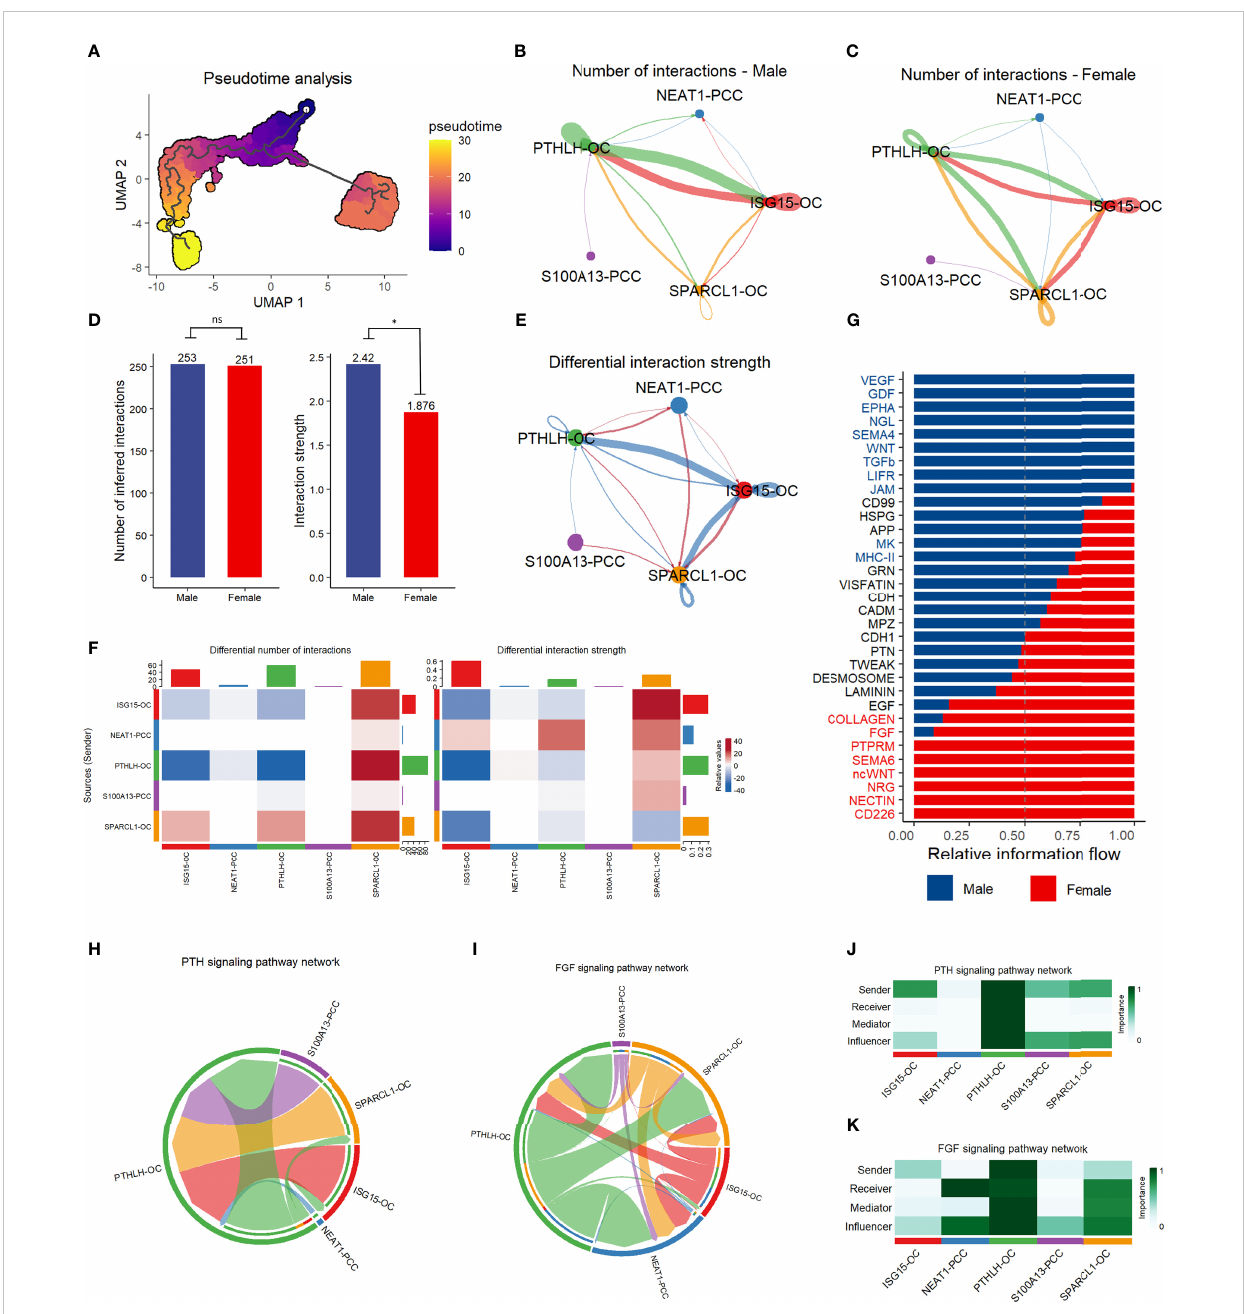
FIGURE 6 Pseudotime trajectory analysis and communication analysis of parathyroid cells. (A) Pseudotime trajectory analysis of parathyroid cell developmental stages. The colormap shows the pseudotime trajectory (B, C) String plot of the aggregated cell-cell communication network of male (B) and female (C) parathyroid cells. (D) Interaction number and strength comparison between male and female patients *= p < 0.05, ns, not statistically signi fi cant (unpaired t-test). (E) Differential interaction strength comparison between male and female patients. (F) Heatmap of interaction numbers and strength in different cell subpopulations. (G) Pathway comparison between male and female patients by parathyroid cell subpopulation. (H, I) String plot of PTH (H) and FGF (I) signaling pathway networks. (J, K) Heatmap of PTH (J) and FGF (K) signaling pathway